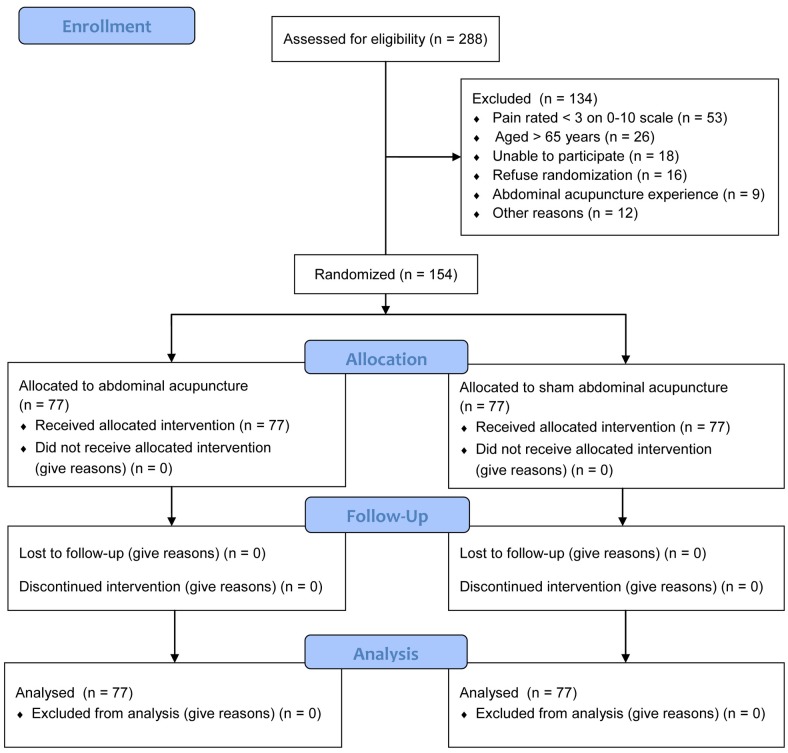
Study flow chart in accordance with the Consolidated Standards of Reporting Trials statement.